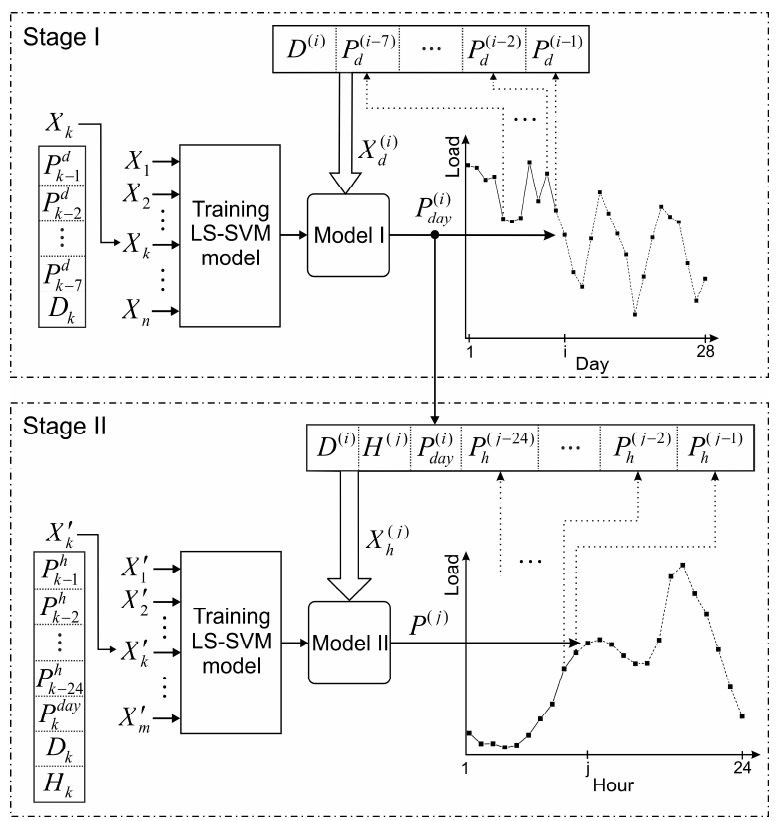
Figure 5. The proposed two-stage model architecture